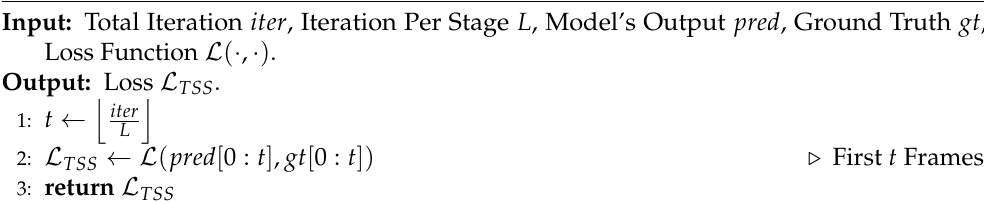
Algorithm 2 TSS